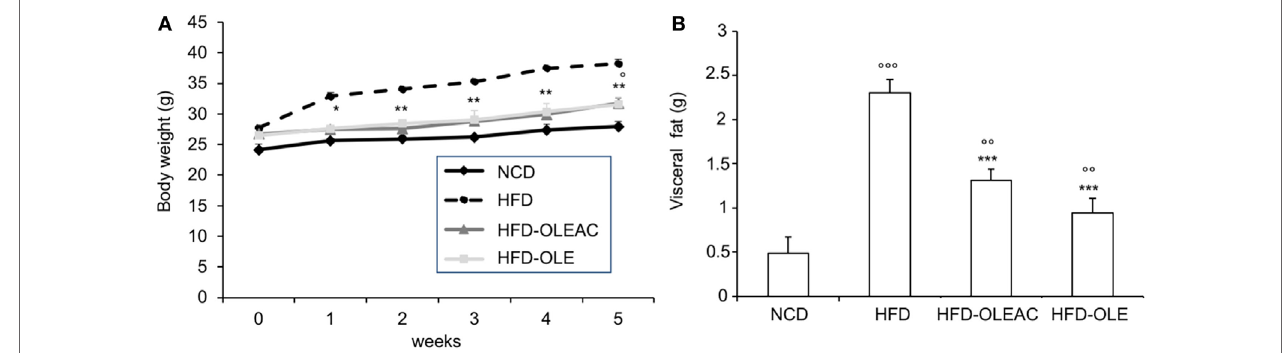
FigUre 1 | Effects of oleacein on body and visceral fat weight in mice fed with high-fat diet (HFD). Body and visceral fat weight were measured in mice fed with normocaloric diet (NCD), HFD, and HFD with oleacein (HFD-OLEAC) or oleuropein (HFD-OLE) during (a) , and at the end (B) of 5 weeks treatment. Values are expressed as mean ± SD. * p < 0.05, ** p < 0.01, *** p < 0.001 vs HFD; ° p < 0.05, °° p < 0.01, °°° p < 0.001 vs